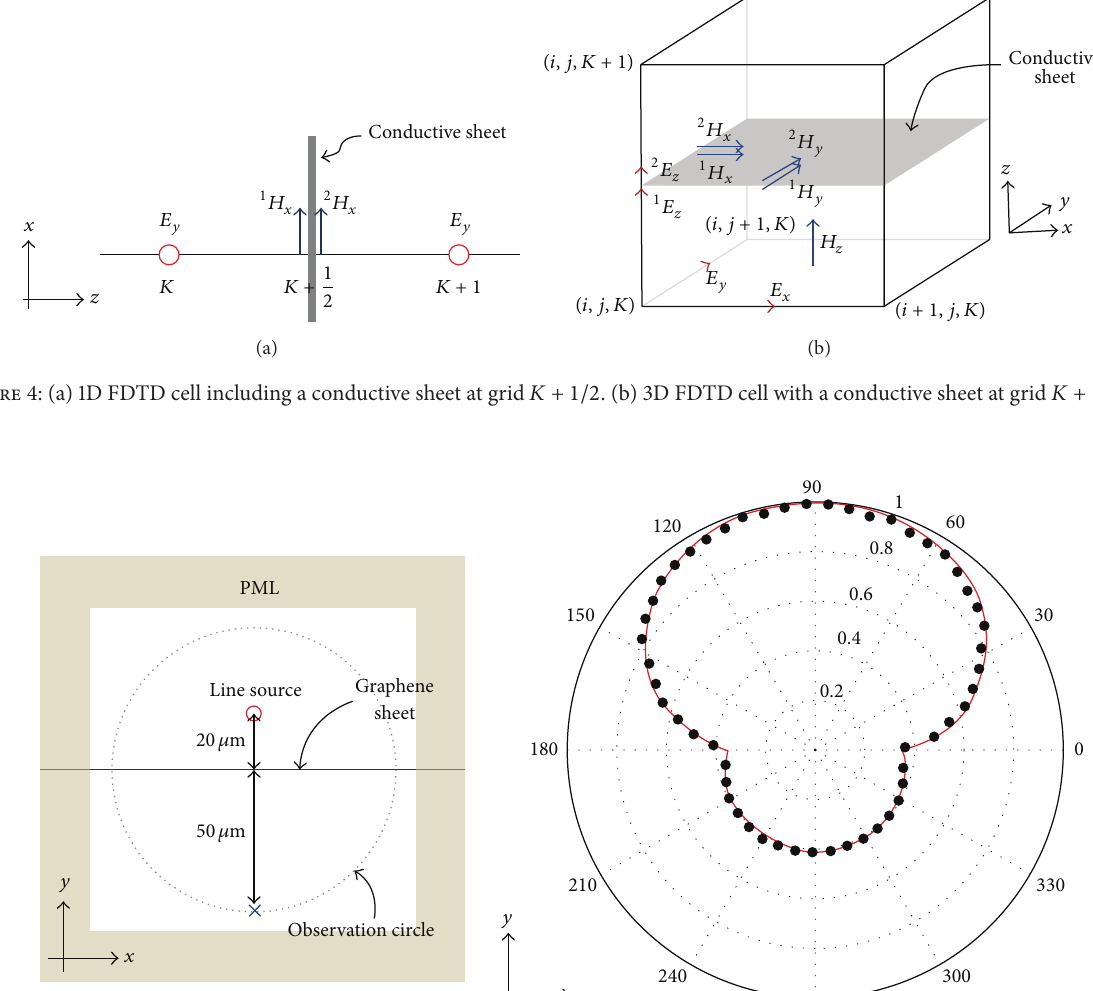
condition to analyze plane wave scattering and